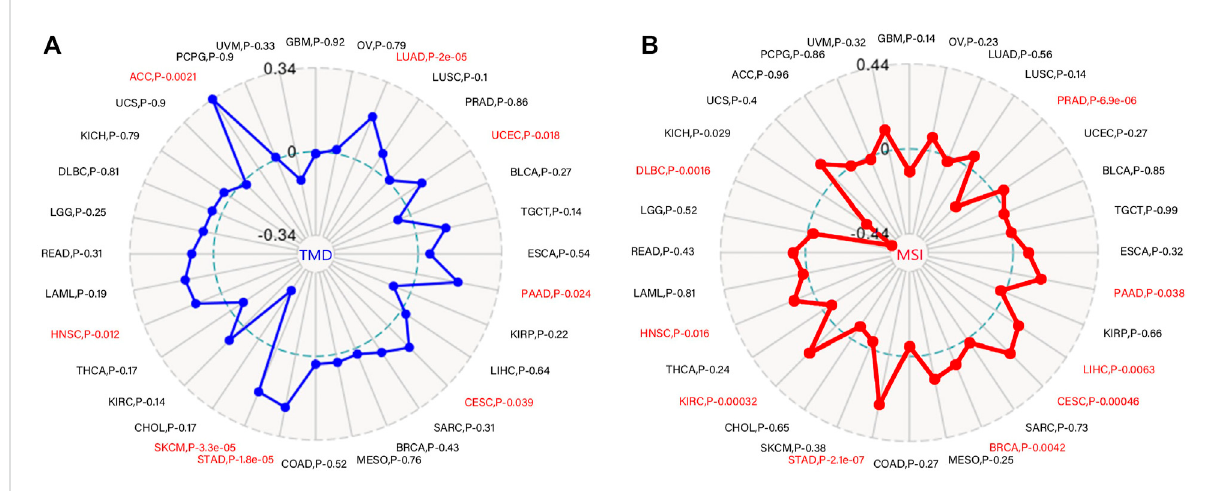
FIGURE 7 Correlations of WDR12 expression with MSI and TMB. (A, B) are radar charts showing the overlaps of WDR12 with TMB and MSI,